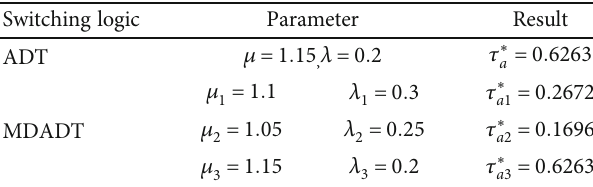
Table 1: Comparison between MDADT switching topologies and ADT switching topologies in